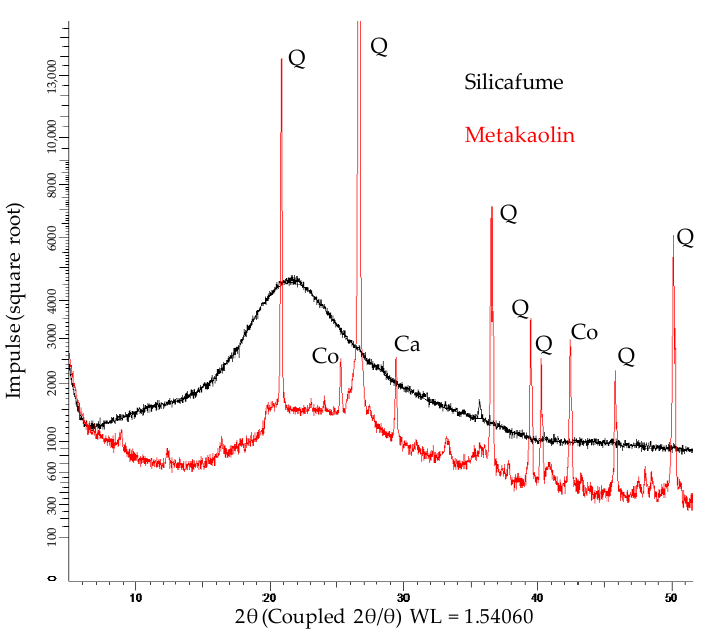
Figure 4. XRD spectra of metakaolin and silica fume (Q: quartz; Co: Corundum; Ca: Calcit).